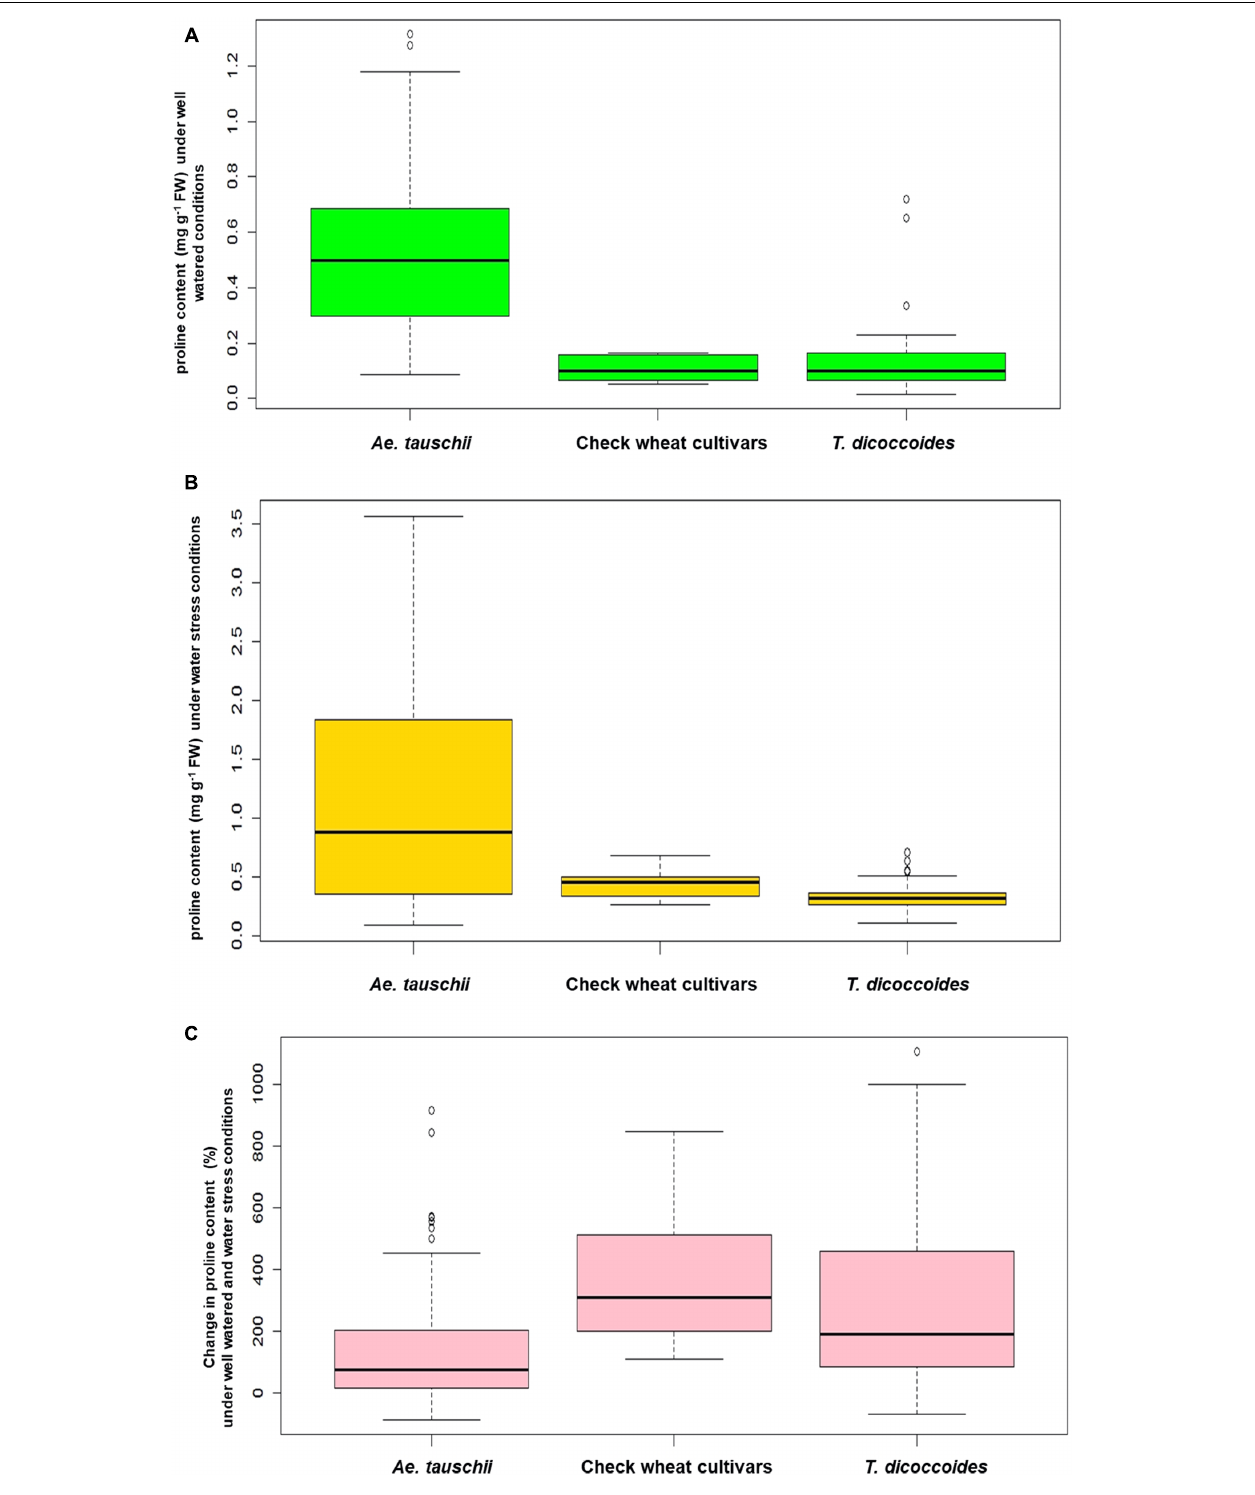
FIGURE 6 | Boxplot representation of proline content in accessions of Ae. tauschii , T. dicoccoides and check wheat cultivars (A) under well watered, (B) water stress and (C) change in proline content under well watered and water stress conditions.